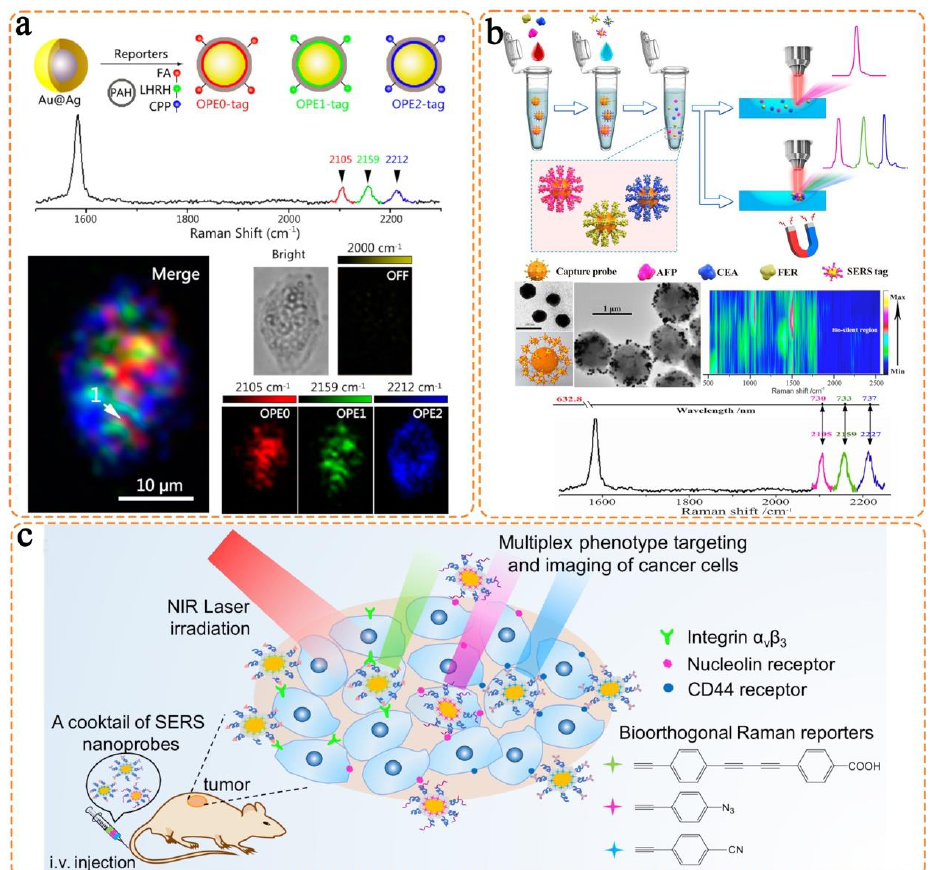
Figure 9. Triple bond-modulated molecules as Raman reporters in SERS nanotags for biomarker detection. ( a ) Three alkyne-containing molecules labeling surface receptors on HeLa cells (i.e., FA, LHRH, and CPP). Reproduced with permission [64]. Copyright 2016, American Chemical Society. ( b ) Three triple bond-containing molecules detecting specific liver cancer antigens (i.e., AFP, CEA, and FER). Reproduced with permission [65]. Copyright 2019, American Chemical Society. ( c ) Three triple bond-containing molecules for breast cancer phenotype detection by detecting three proteins on CTC surfaces (i.e., integrin α v β 3 , nucleolin receptor, and CD44 receptor). Reproduced with permission [66]. Copyright 2019, American Chemical